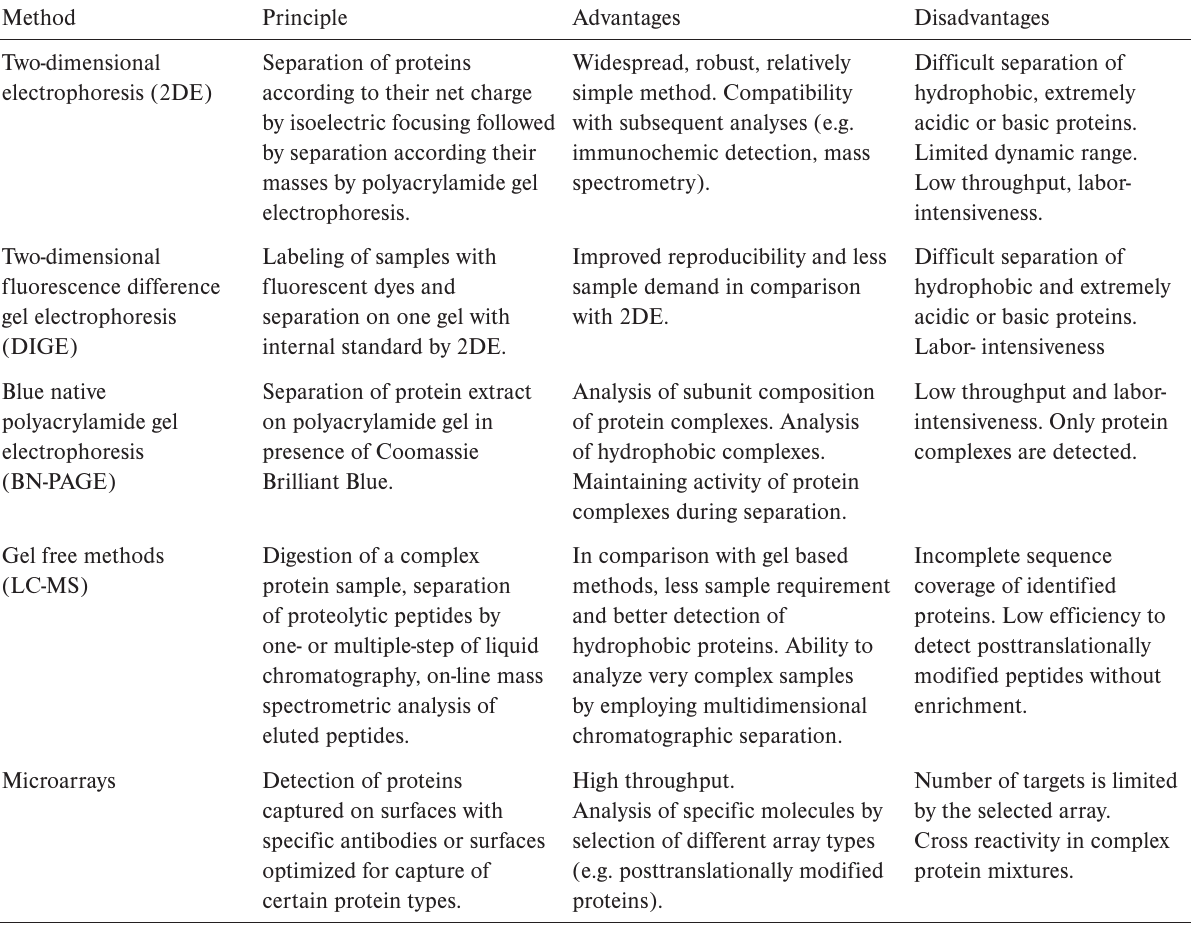
Table 1. Summarization of proteomic methods and their suitability for analysis of mitochondrial proteome. Method Principle